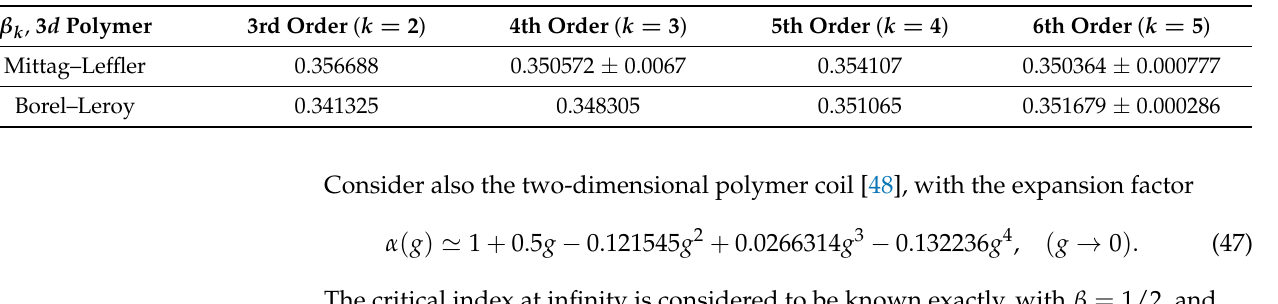
Table 2. Critical index β for the expansion factor of three-dimensional polymer chain. Dependencies on the approximation order corresponding to the number of coefficients a n employed in the course of